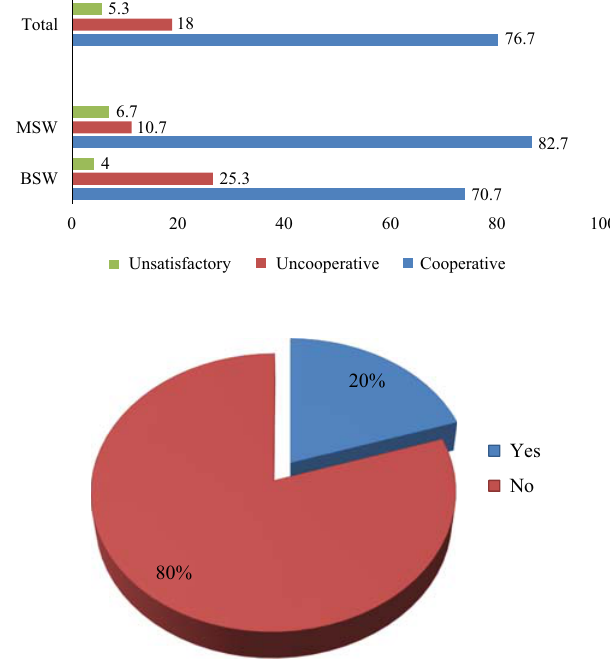
Figure 6. Academic counsellors views on student ’ s